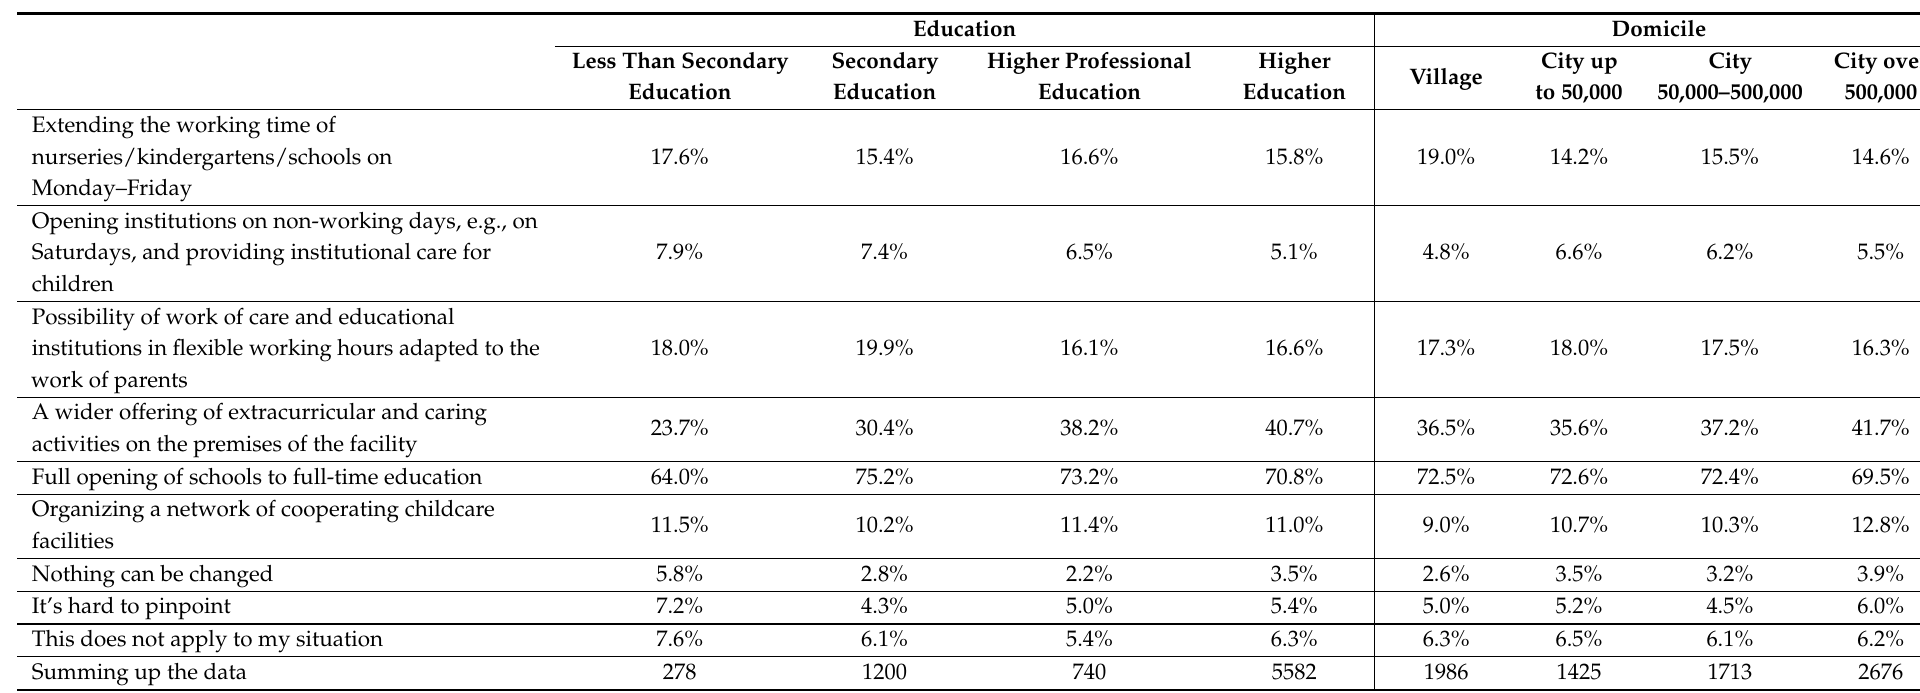
Table 3. Solutions by the education system that could help in reconciling work and private life during the pandemic (education and domicile) (n =